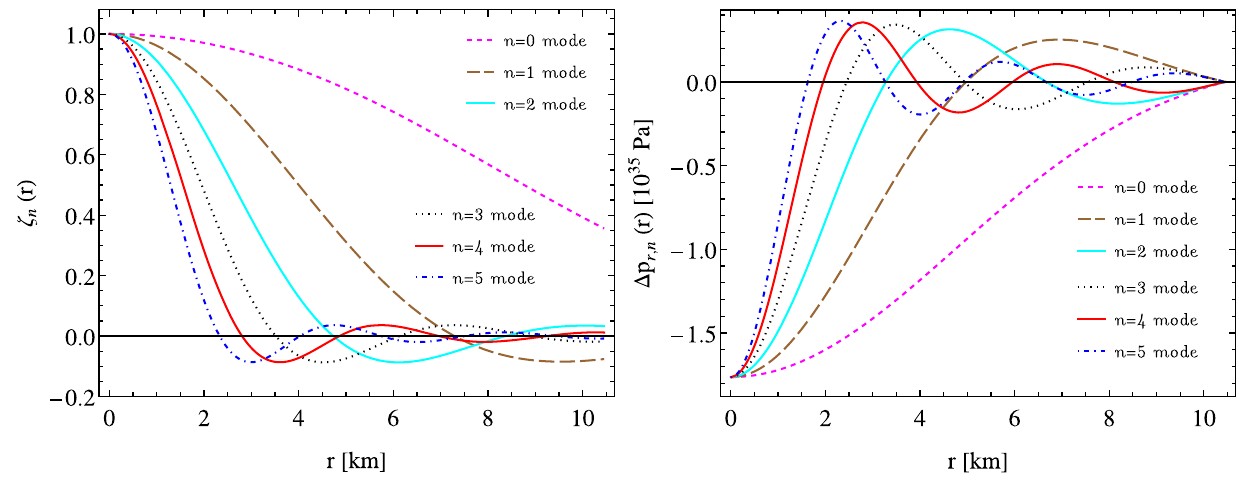
n th vibration mode contains n nodes in the internal structure of the star. Note that the eigenfunctions ζ n ( r ) have been normalized assuming ζ = 1 at r = 0, and the Lagrangian perturbation of the radial pressure (cid:15) p ( r ) obeys the boundary condition (11) at the stellar surface. Since r , n f 0 is real, this configuration corresponds to a stable anisotropic dark energy star